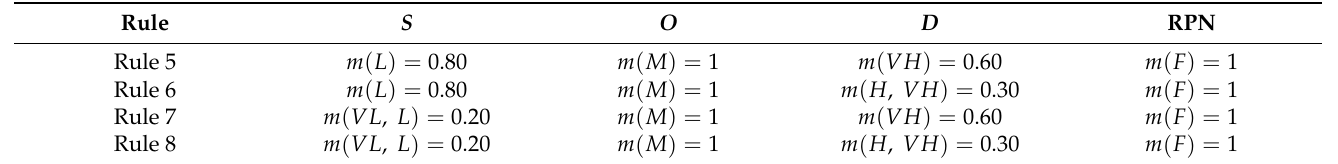
Table 4. Fuzzy ER rules for S = 2, O = 5, and D =